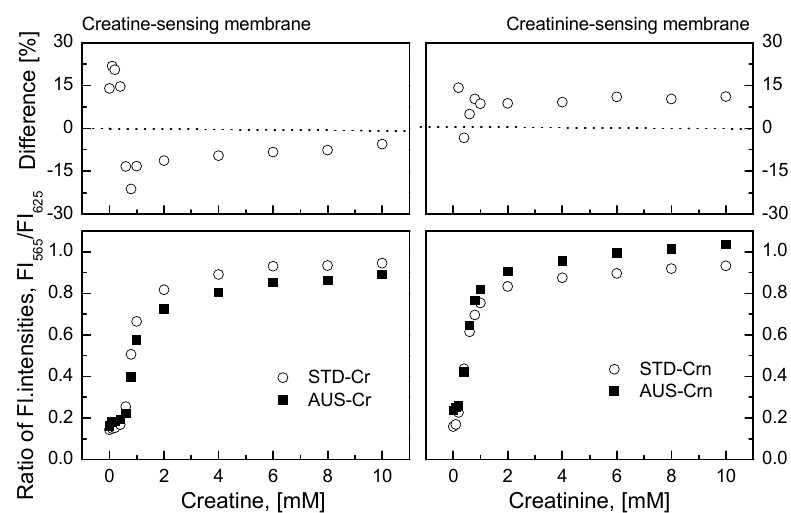
Figure 11. Comparison of creatine (Cr) and creatinine (Crn) concentrations in standard solution (STD) and artificial urine solution (AUS) using creatine- and creatinine-sensing membranes, and their difference plots. The difference represents 100 × (creatine or creatinine in AUS − standard creatine or creatinine)/(standard creatine or creatinine). The dashed lines indicate the recovery percentage of 85–115% for creatine or creatinine in AUS samples.